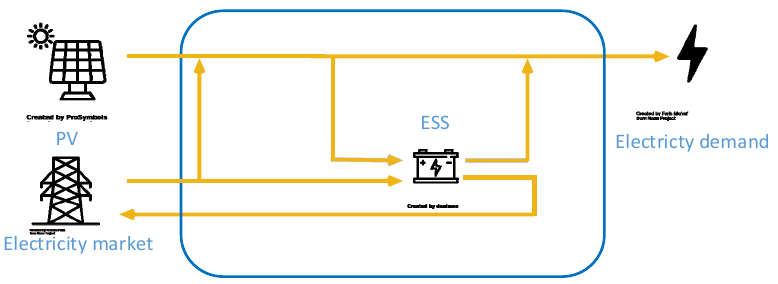
Figure 9. Schematic of ESS connections.